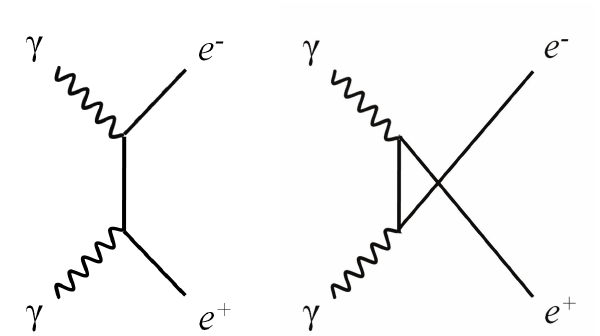
Figure 6. Feynman diagrams for the photon pair-production process. The diagram on the left corresponds to the t channel, whereas the one on the right corresponds to the u